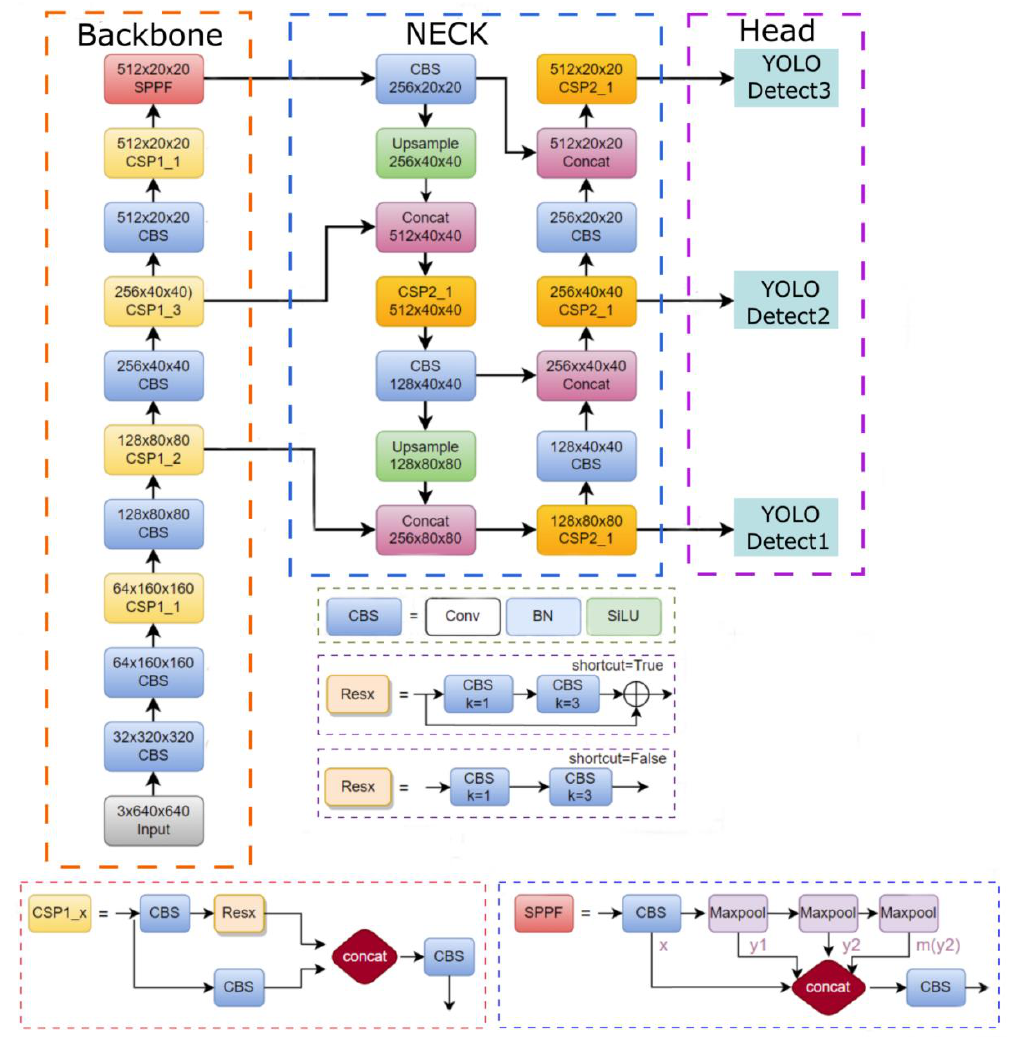
Figure 3. YOLOv5 network architecture diagram.